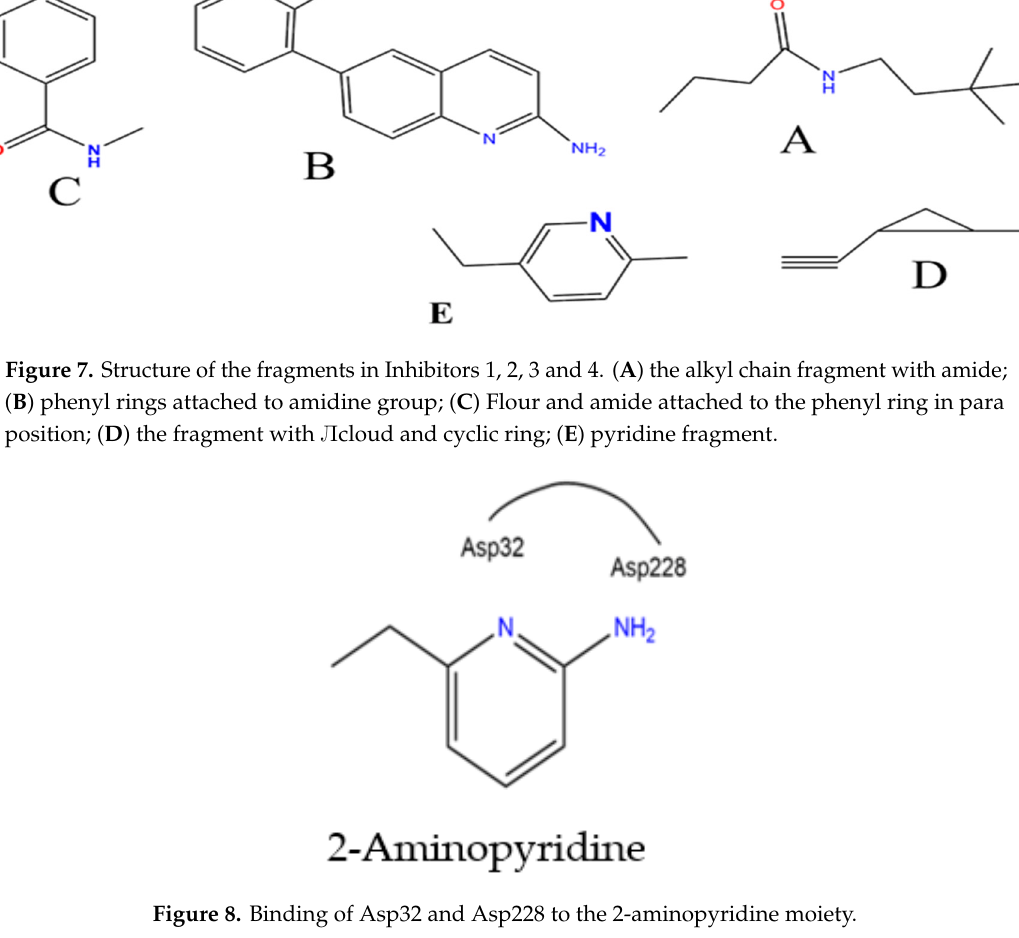
Figure 8. Binding of Asp32 and Asp228 to the 2-aminopyridine moiety.